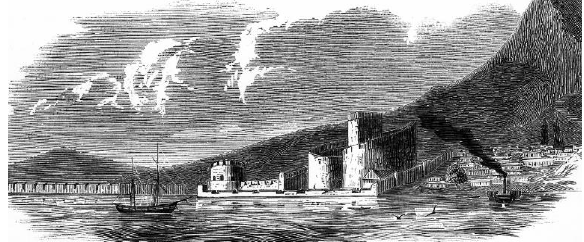
Figure 06 : Gravure 04: Gravure of Kilitbahir Castle and Namazgah Redoubt dated 1853 titled "L'Illustration: Journal